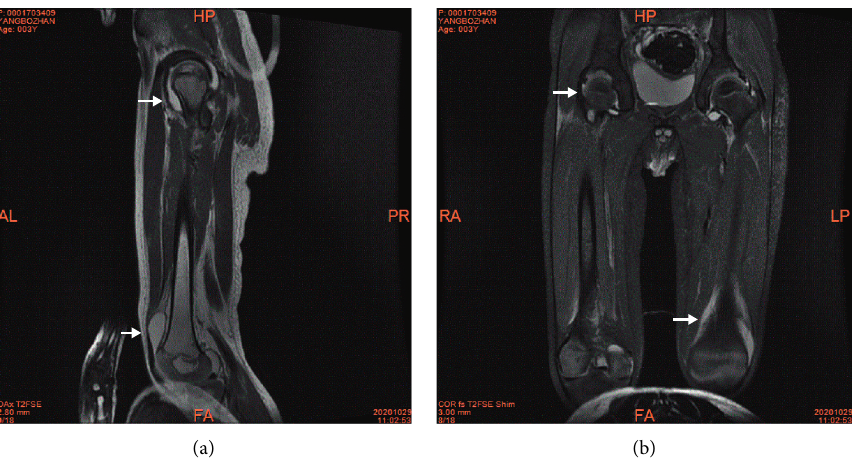
Figure 2: T2-weighted imaging in the acute phase of Kawasaki disease. There was a long T2 signal in the bilateral hips, knees, and bursae suprapatellaris (a), (b), which indicated arthritis with effusion, while there was an inflammatory edema signal in thigh skeletal